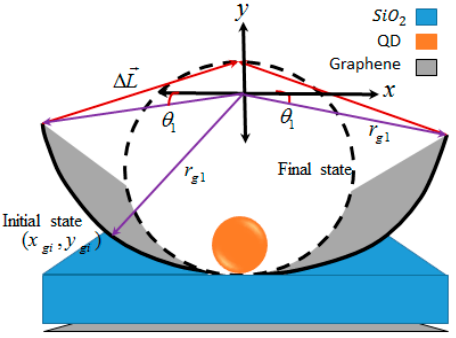
Figure 5. Introduction of the vector ∆ L . In addition, schematic representation of the cross-section of the SWCNT, and visual expression of the bending management of the charged graphene nanoribbon sheet with the help of the bending vector ∆ L .